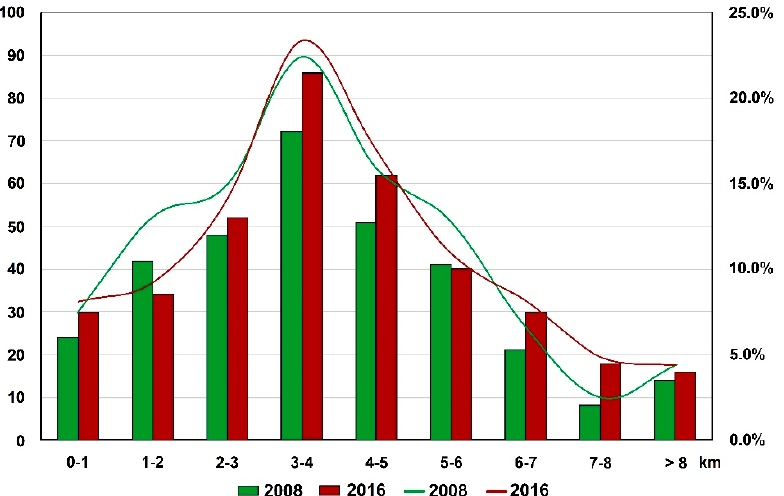
Figure 5. The number of high-technology industrial entities and their share in total depending on the distance from the city center in 2008–2016 (sourced by authors).